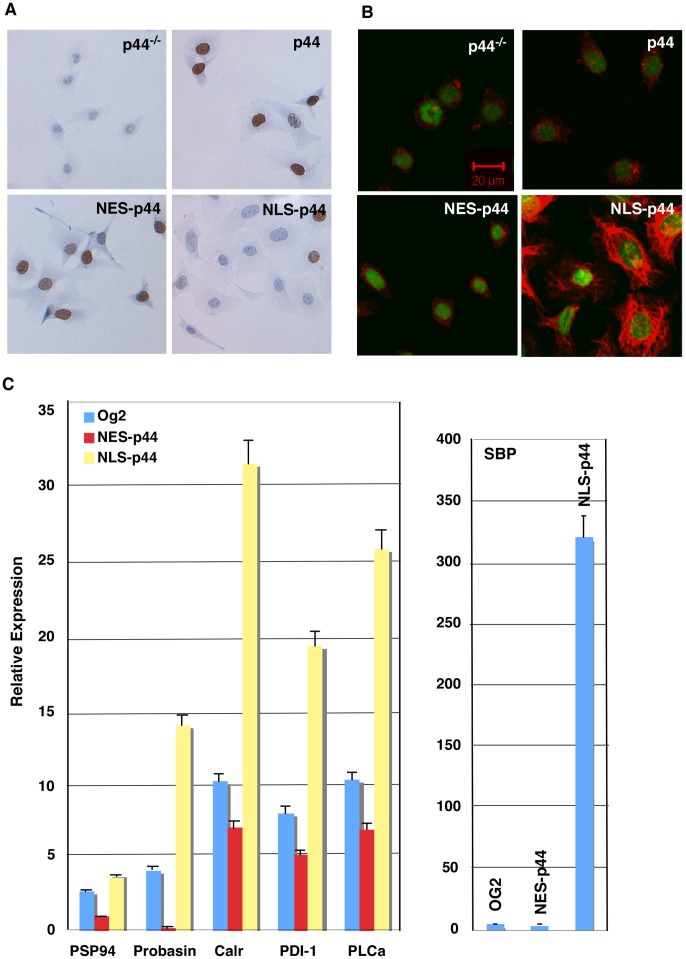
Nuclear p44 promotes differentiation of prostate epithelial cells.(A) Cytoplasmic p44 is required for proliferation of prostate epithelial cells. P44-null prostate epithelial cells infected with control lentivirus or lentivirus expressing p44, NES- p44, or NLS-p44 were allowed to grow in the presence of BrdU and immunostained with an anti-BrdU antibody (shown brown). (B) Nuclear p44 enhanced CK18 expression. P44-null prostate epithelial cells infected with control lentivirus or lentivirus expressing p44, NES-p44, or NLS-p44 were immunostained for CK18. (C) Nuclear p44 (NLS-p44) enhanced expression of prostate-secreted proteins by quantitative RT-PCR analysis of expression of prostate-secreted proteins. Total RNAs were isolated from p44-null prostate epithelial cells infected with control lentivirus (Og2) or lentivirus expressing p44, NES-p44, or NLS-p44 and amounts of RNAs were measured by real-time PCR. Relative expression indicated specific mRNA levels divided by β-actin mRNA levels. One-way ANOVA analysis: for PSP94 gene, F = 1,297, p<0.0001, R square = 0.9870; for probasin gene, F = 1,198, p<0.0001, R square = 0.9965; for Calr gene, F = 1,140, p<0.0001, R square = 0.9938; for PDI gene, F = 1,149, p<0.0001, R square = 0.9927; for PLCa gene, F = 1,385, p<0.0001, R square = 0.9917; and for SBP gene, F = 1,203, p<0.0001, R square = 0.9974. The p value of unpaired Student’s t-Test of data between Og2 and NES-p44 or NLS-p44 epithelial cells: 0.0103 or <0.0001 (PSP94), <0.0001 or <0.0001 (Probasin), 0.0381 or <0.0001 (Calr). 0.0005 or <0.0001 (PDI-1), 0.126 or <0.0001 (PLCa), and 0.5019 or <0.0001 (SBP).